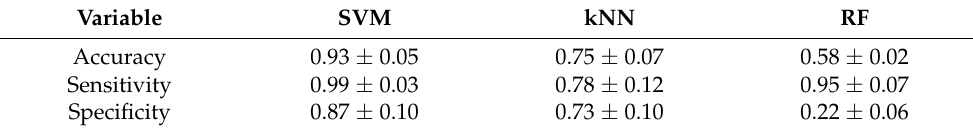
Table 5. Performance metrics for each classifier, FARSEEING test set for overlapping approach (50% overlapping epochs). All classifiers have been trained on a SisFall set and evaluated using a FARSEEING test set, from which the metrics have been calculated. SVM achieved the best results with the highest classification metrics. The values are mean ± standard